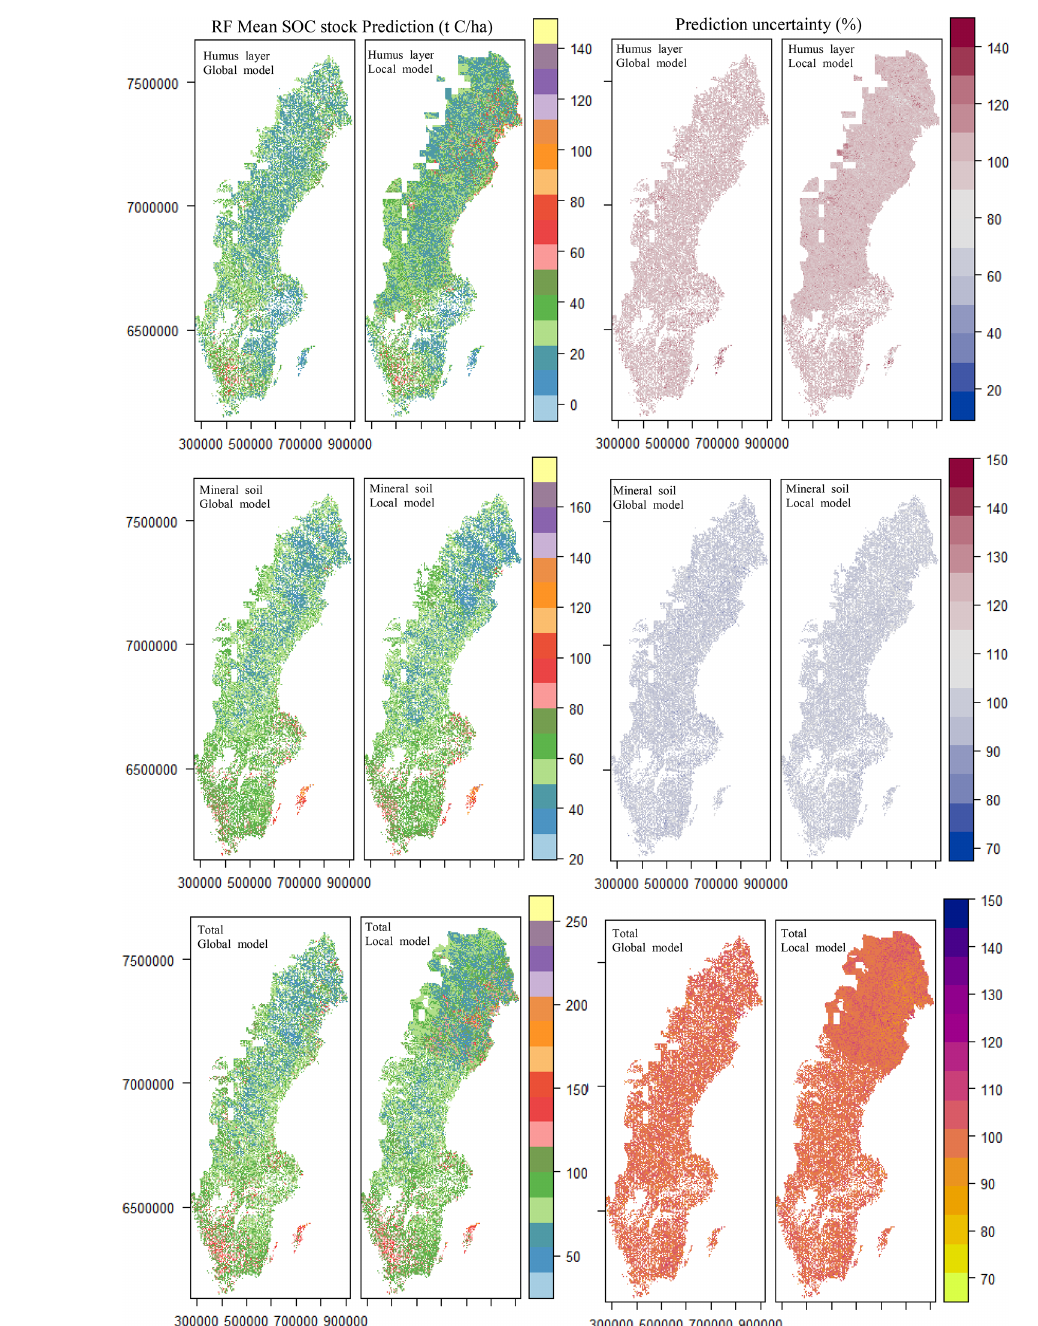
Figure 6. Mean SOC stock prediction and prediction uncertainties of the spatial distribution of the humus layer, mineral soil, and total SOC stock based on the group of